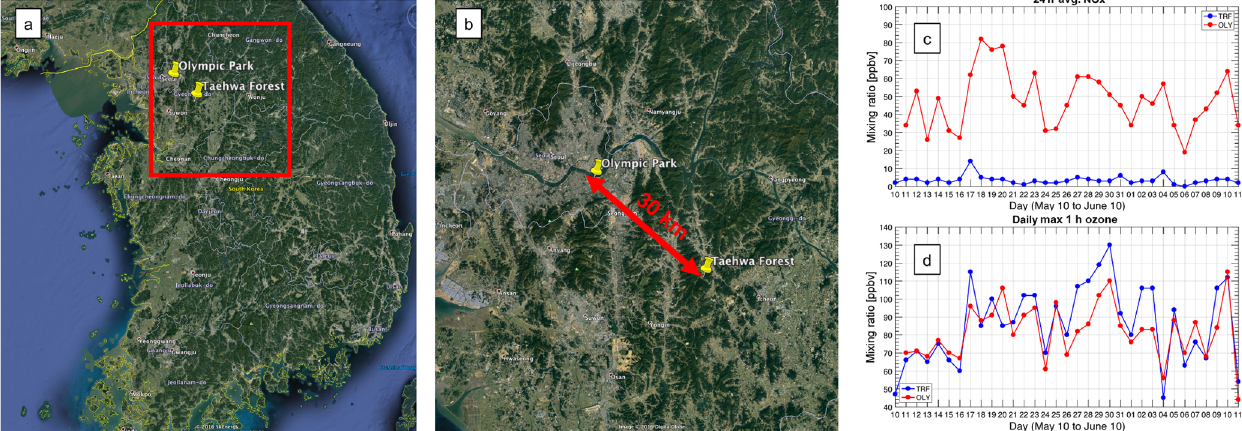
Figure 1. (a) Map of the Korean Peninsula, (b) inset view (red square from a ) of the Olympic Park and Taehwa Research Forest sites, (c) daily average NO x and (d) maximum hourly O 3 at the TRF and OLY